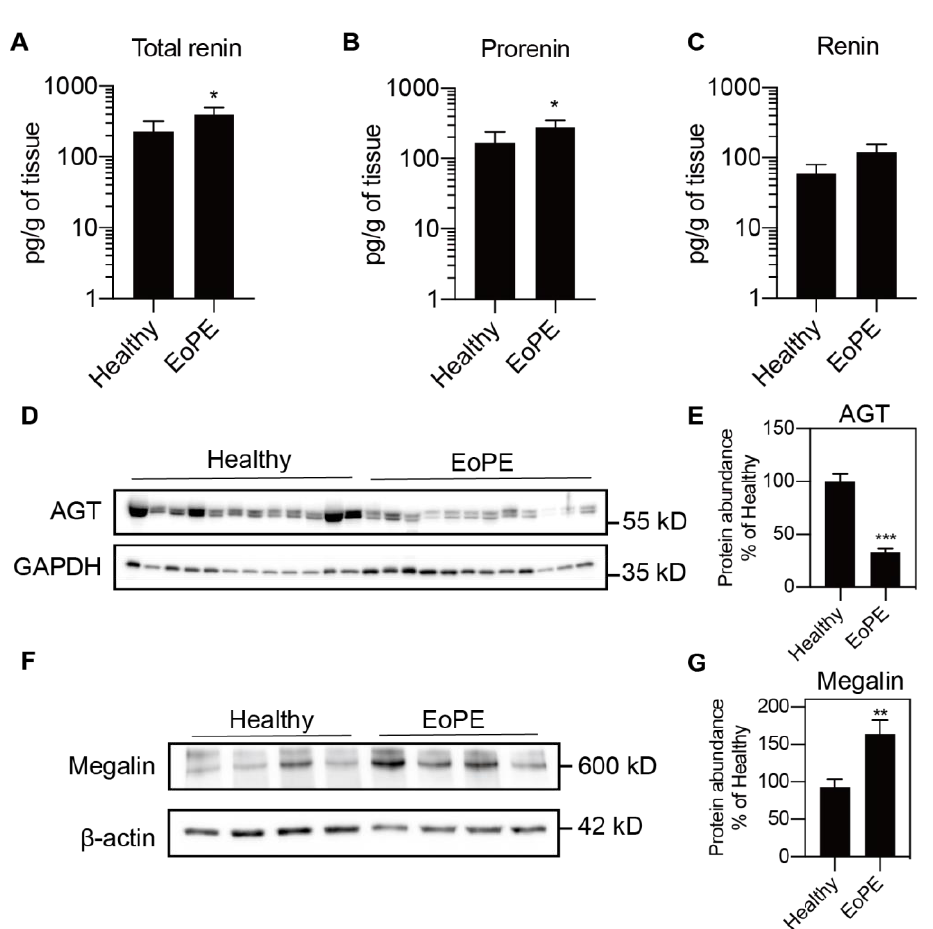
Figure 2. Total renin ( A ), renin ( B ) and prorenin ( C ) levels ( n = 16) measured by immunoradiometric assay and angiotensinogen (AGT; D , E ) and megalin ( F , G ) protein abundance ( n = 12) measured by Western blot in healthy and early-onset pre-eclamptic (EoPE) placental tissue. Panels ( D , F ) are representative blots of AGT and megalin protein. Data were normalized versus GAPDH ( E ) or β-actin ( G ). Data are mean ± SEM. * p < 0.05, ** p < 0.005, *** p < 0.0005 vs. Healthy. AGT, angiotensinogen.